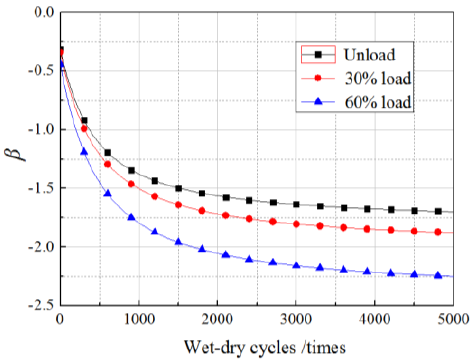
Figure 4. Change of β with wet–dry cycles.